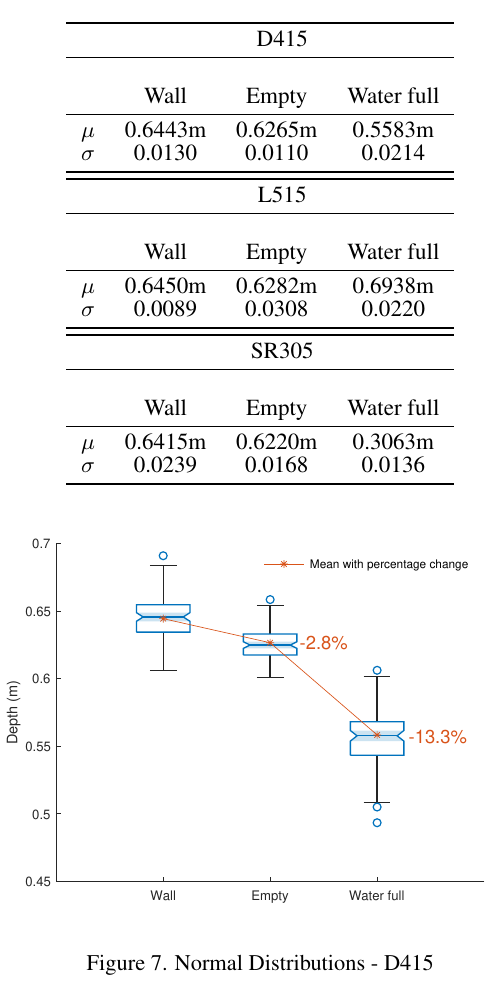
Table 1. Estimated parameters resulting from fitting to a normal distribution. µ - Mean and σ - Standard deviation.